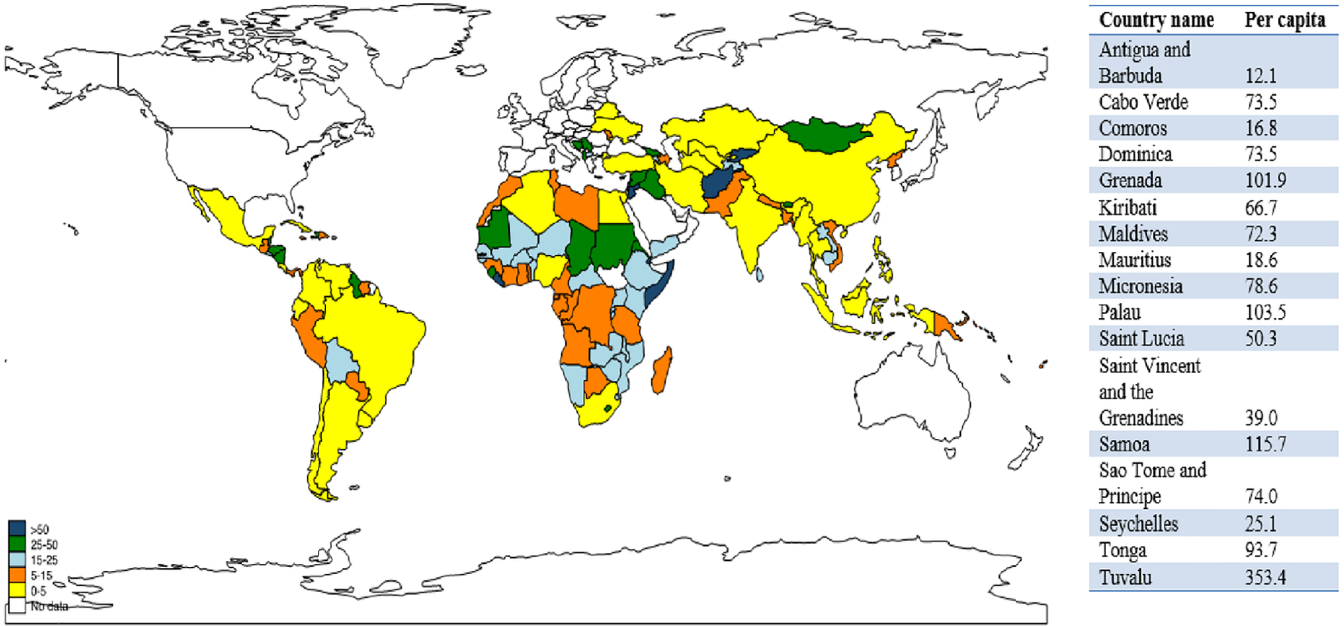
Fig 4. Upper-bound per capita aid for child survival in 134 countries over the 15-yearperiod.